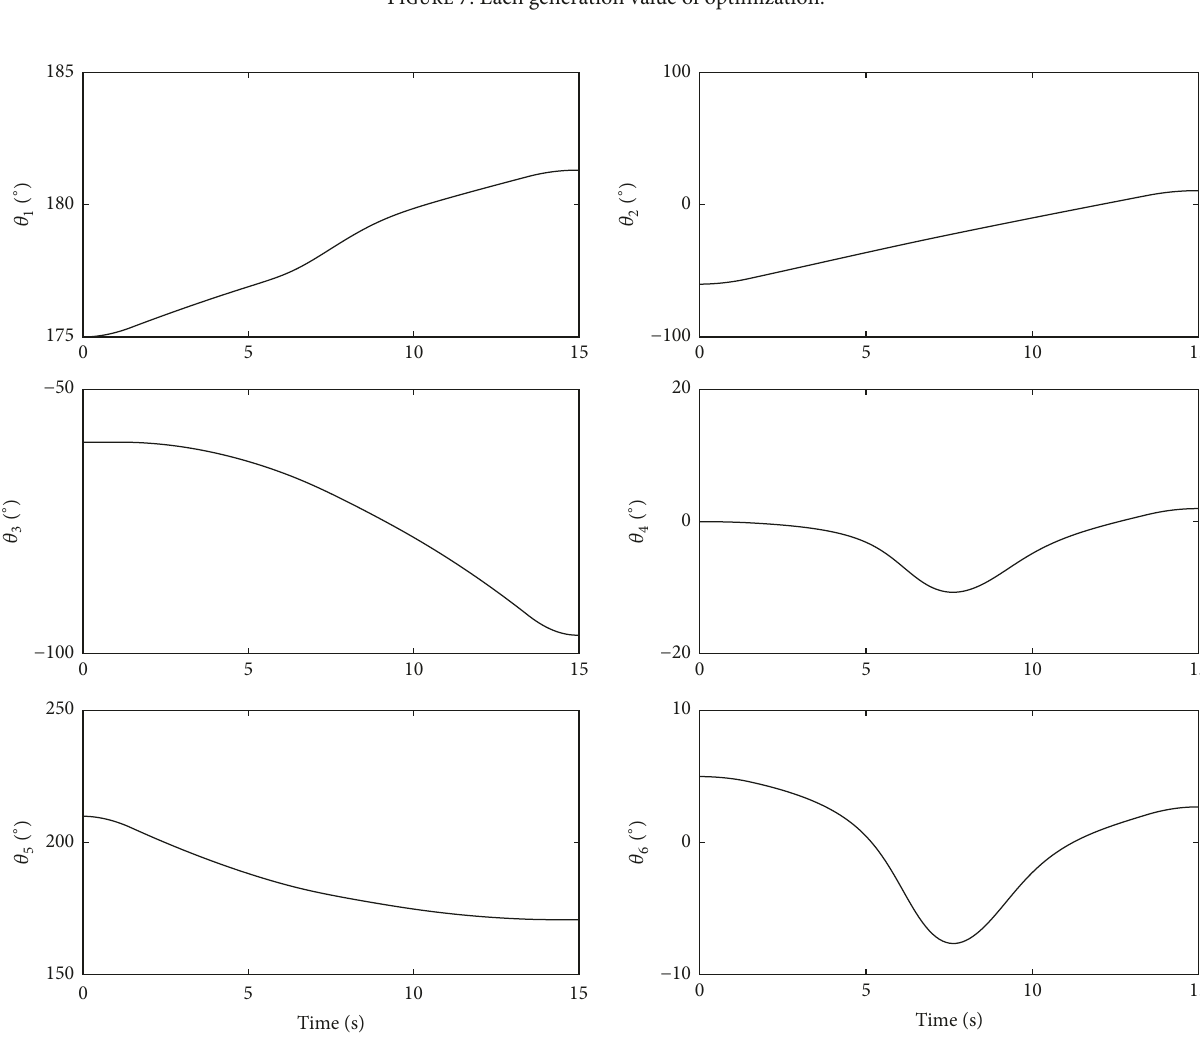
Figure 7: Each generation value of optimization.